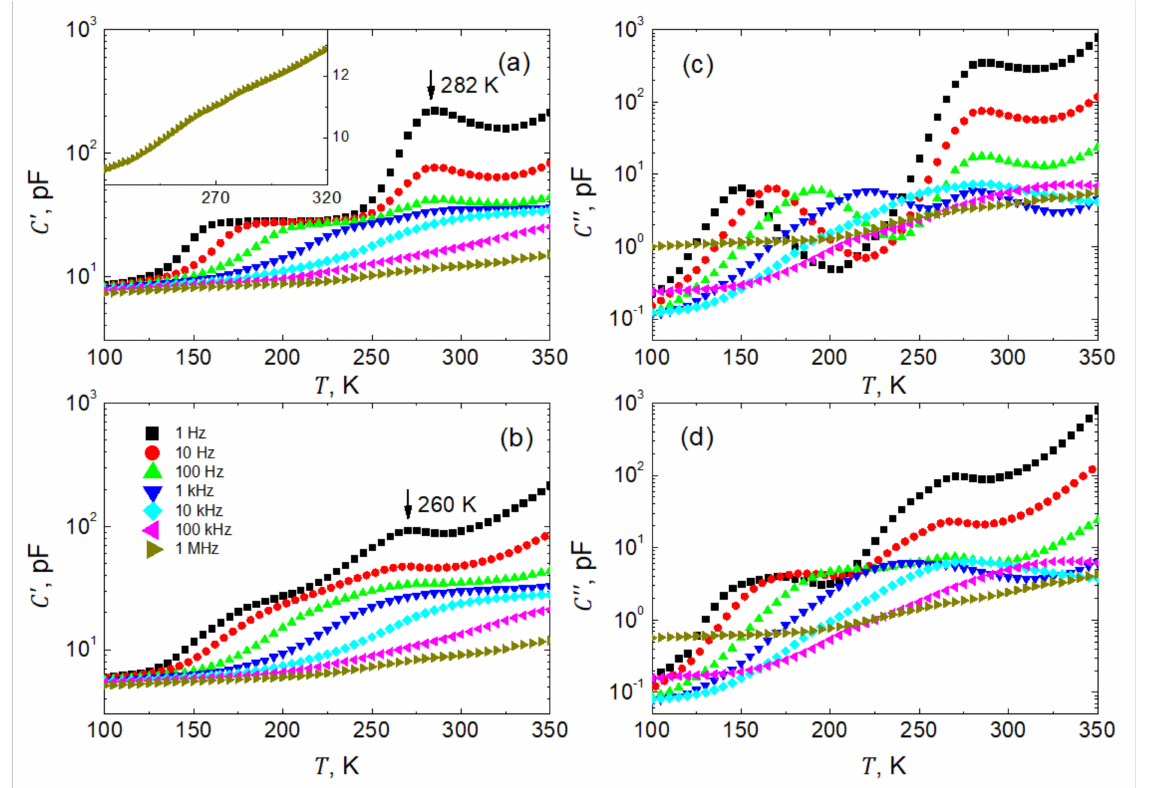
Figure 4. Temperature dependences of real, C (cid:48) ( a , b ), and imaginary, C (cid:48)(cid:48) ( c , d ), parts of the complex capacitance of SbSI sample measured at decade stepped frequencies within 10 0 ≤ f ≤ 10 6 Hz during heating ( a , c ) and cooling ( b , d ) run, respectively. For the sake of clarity, only every fifth experimental point is shown. The inset shows the C (cid:48) ( T ) dependence for 1